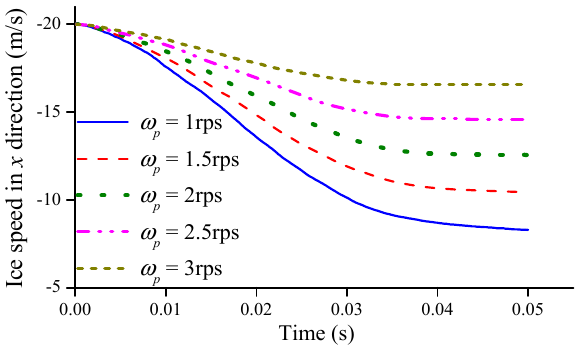
Figure 16. Time series of ice speed in the x direction based on simulations with di ff erent rotation speeds.